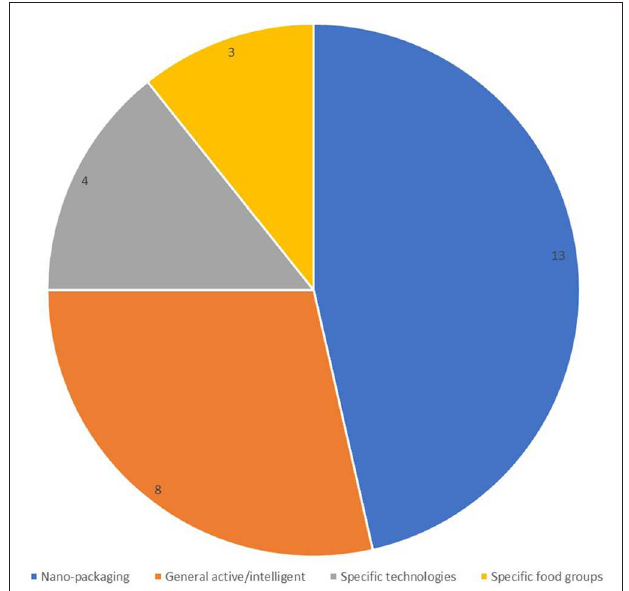
FIGURE 3 | Technological focus of the